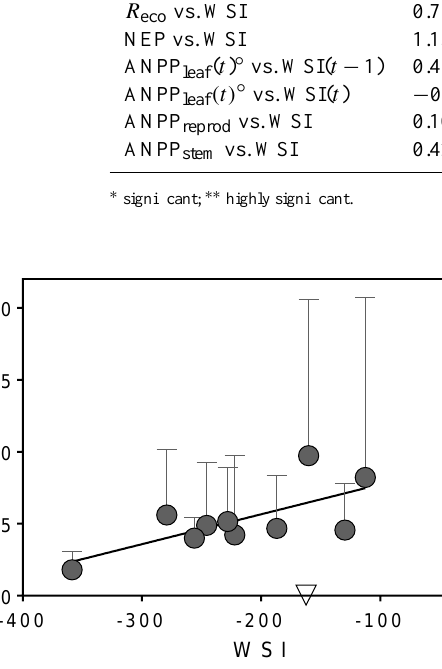
Figure 5. Ordinary least-square regression line between the WSI and the net productivity of the reproductive effort (flowers and fruits; error bars are standard deviation). WSI is expressed in MPa day and ANPP reprod in gCm − 2 yr − 1 . Data from 2005 that were not used in the analysis were also plotted (empty